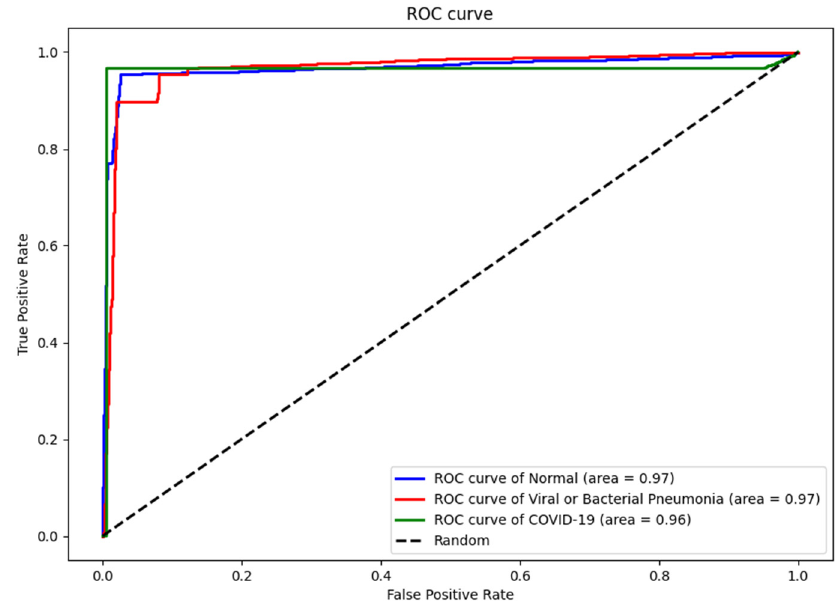
Figure 14. ROC curve for the ResNet50 model on the test dataset.